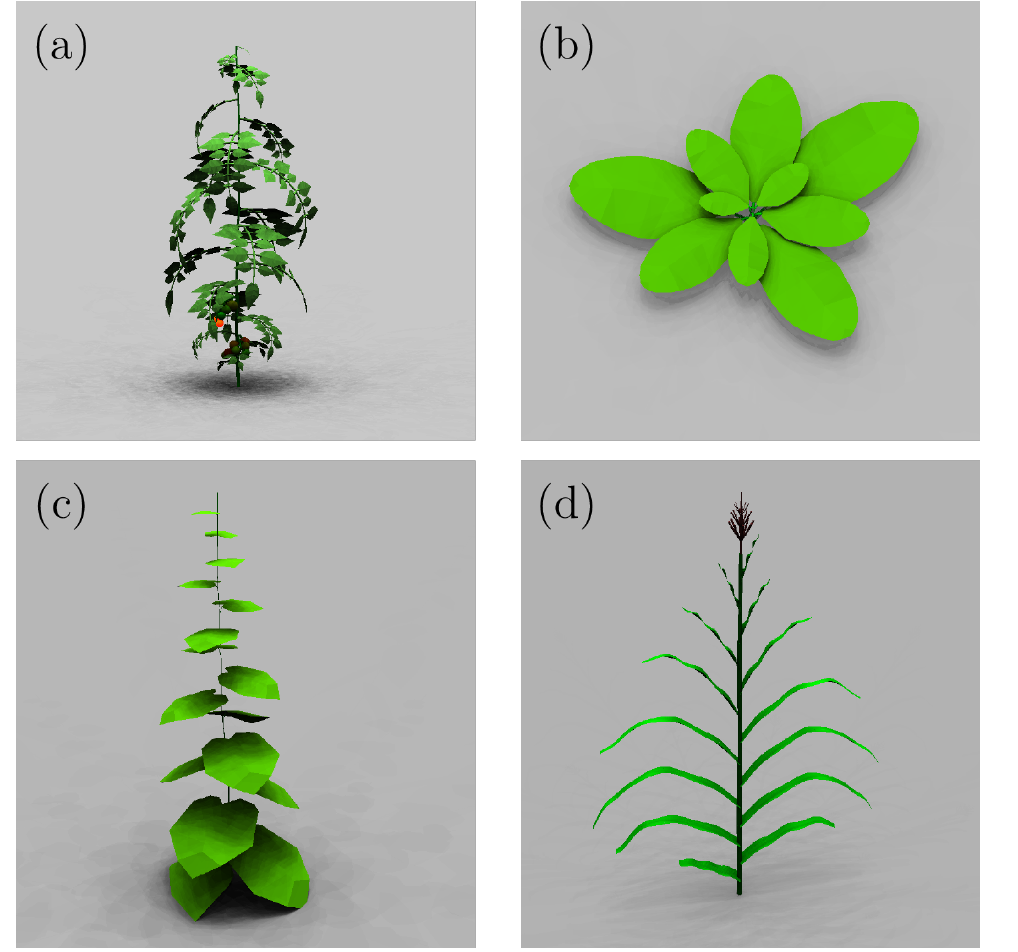
Figure 1. Screenshots of rendered images of the four plant shoot models used within this study including ( a ) tomato, ( b ) arabidopsis, ( c ) greenhouse cucumber, and ( d )